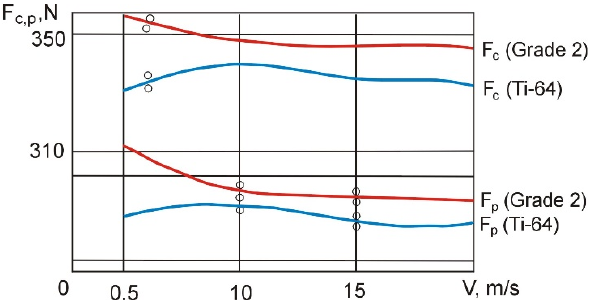
Figure 4. Experimental curves of changes in the F c and F p cutting force components as a function of the cutting speed during